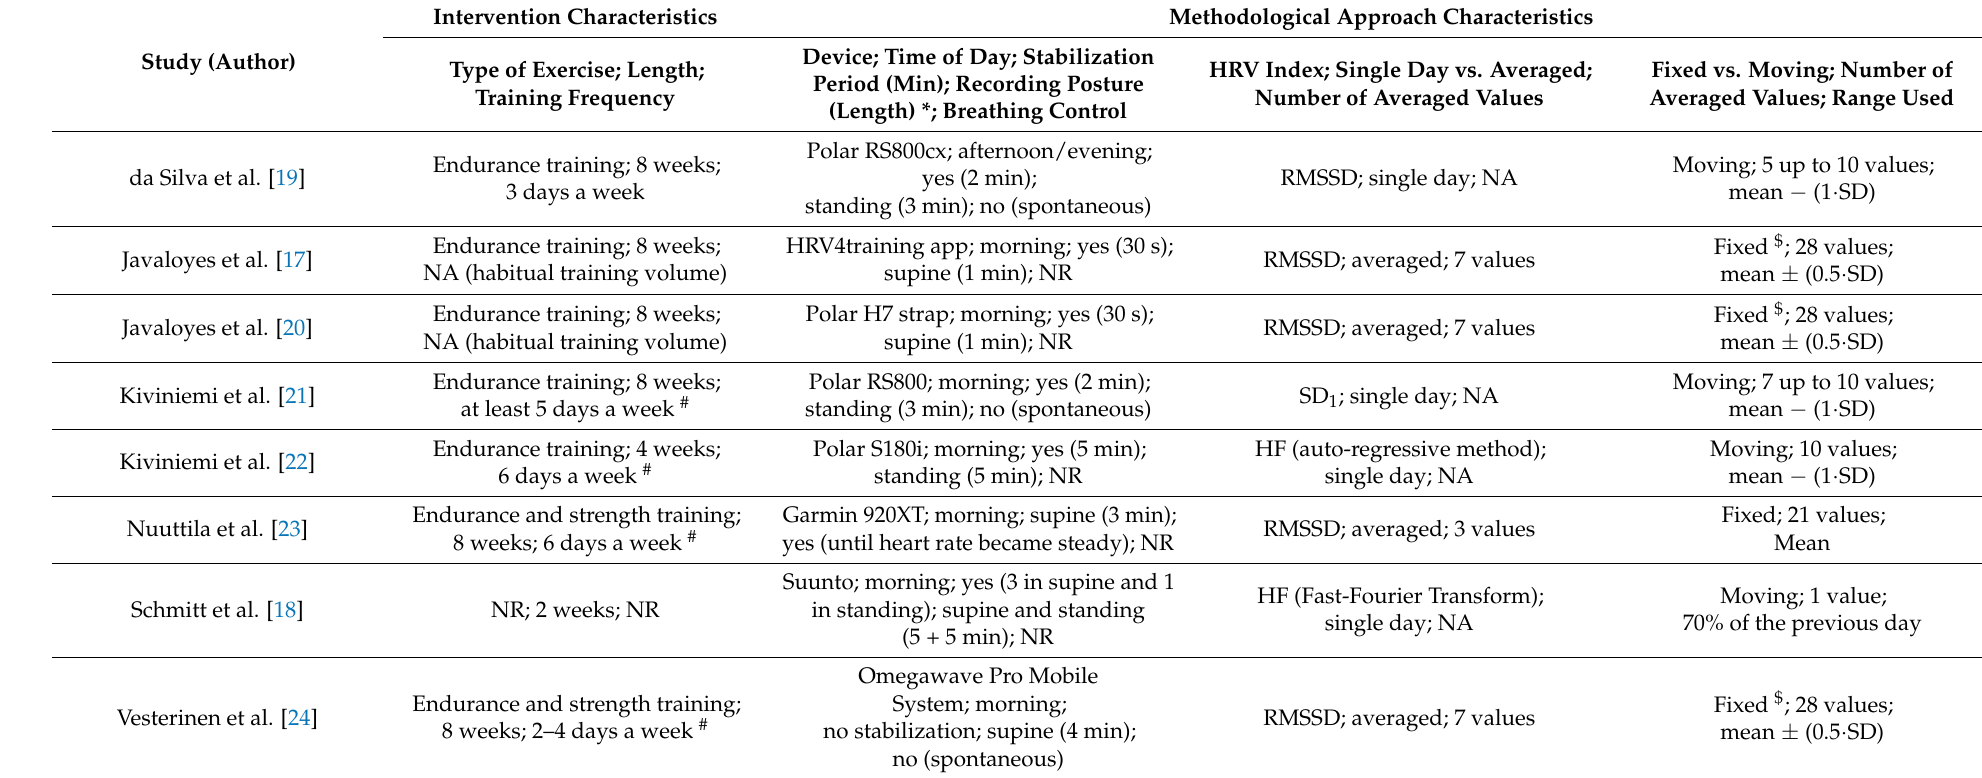
Table 2. Intervention and methodological approach